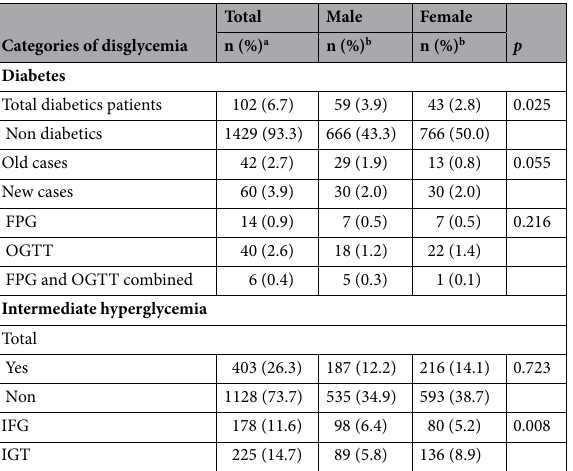
Table 3. Dysglycemia in the population of Gombe Matadi (n = 1531 participants). a % according to the total of the sampling. b % according to the column of total per lign.